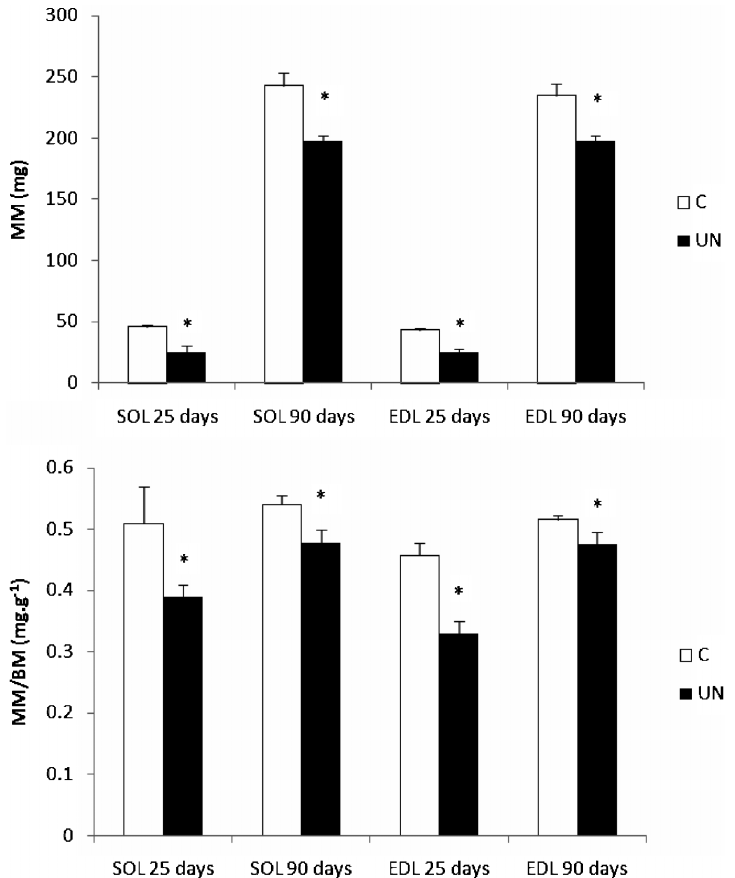
Figure 3 - Absolute muscle mass (MM) and ratio muscle mass to body mass (MM/BM) of soleus and EDL muscles at 25 and 90 days of age. C: control group; UN: undernourished group. *p , 0.05